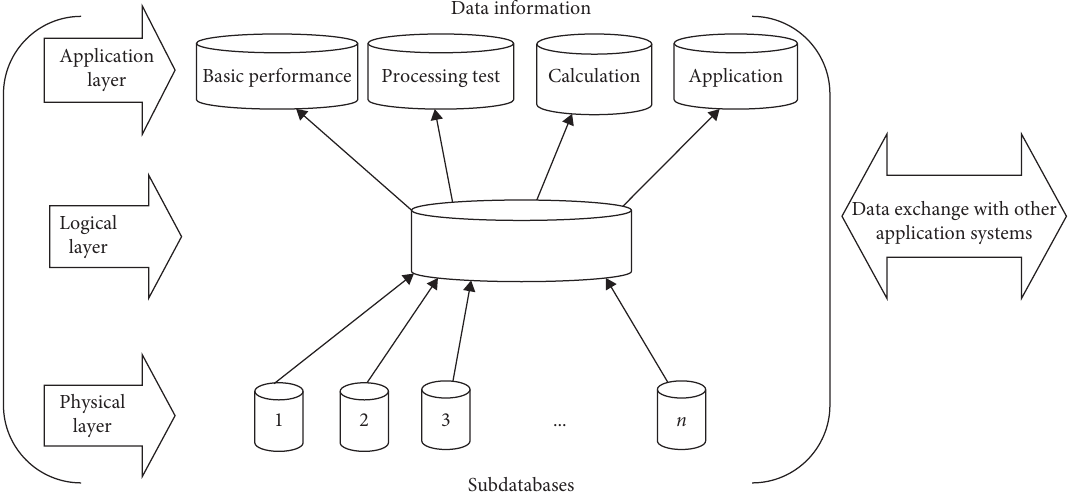
Figure 4: Structural design drawing of materials database.